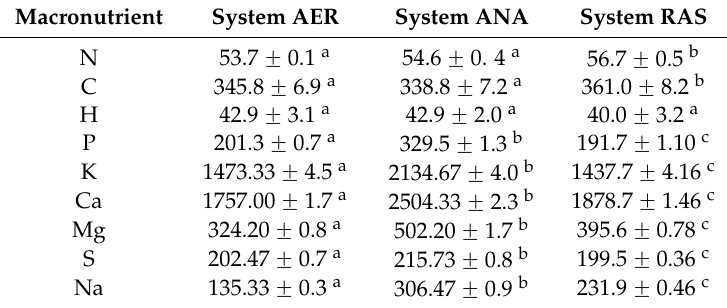
Table A1. Mean values (± SD) of nutrient content (in mg/g) of the lettuce shoots of each system.